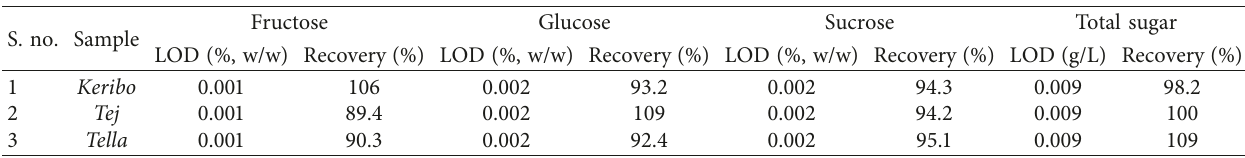
Table 4: Limit of detection and recovery percentage for individual sugars by the HPLC-RI method and for total sugar by the sulfuric acid method.